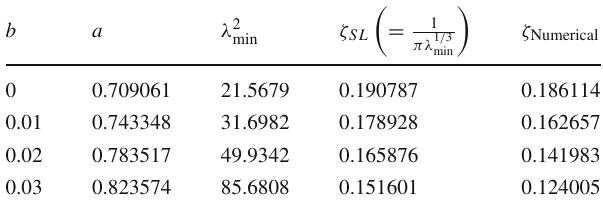
Table3 Comparisonofanalyticalandnumericalvaluesof ζ = T c /ρ 1 / 3 for α = 0 .